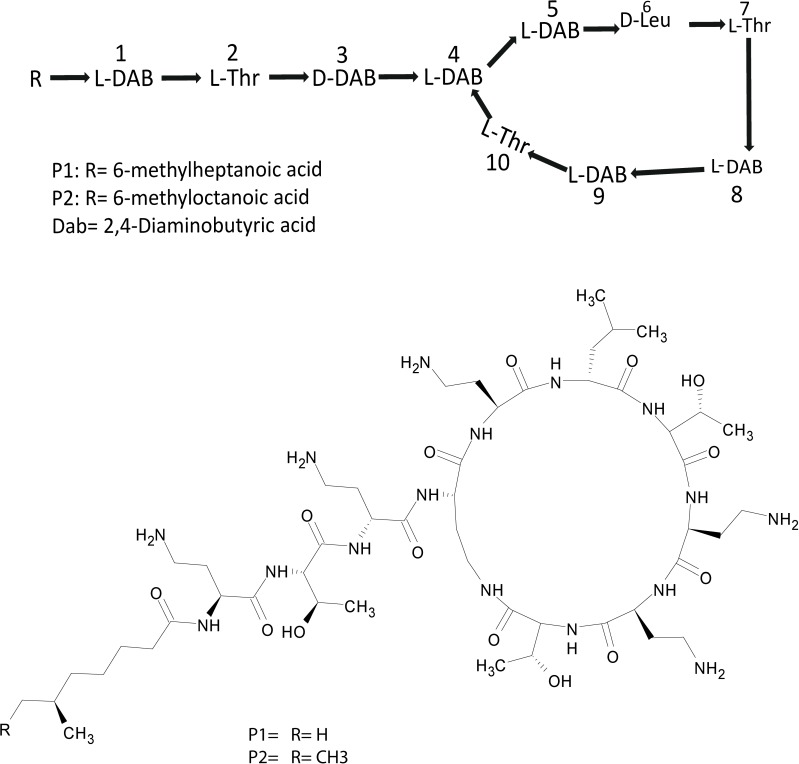
Proposed 2D structure of P1 and P2.